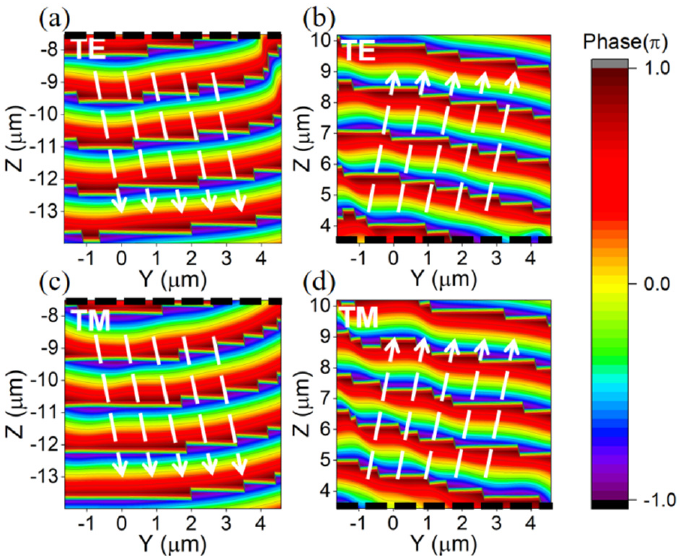
Figure 3. The Y − Z plane phase diagrams of the reflective and transmissive ends of the metasurface beam splitter under two types of line-polarized incident light at 1.55 µ m wavelength reflect the isophase plane of the outgoing light waves, with white arrows in the direction of the isophase plane vertical line, a black dashed line being the light-emitting surface of the metasurface, and different color stratifications representing different isophase planes. ( a ) The isophase plane of the reflective end under the incident x-line polarized light. ( b ) The isophase plane of the transmissive end under the incident x-line polarized light. ( c ) The isophase plane of the reflective end under the incident y-line polarized light. ( d ) The isophase plane of the transmissive end under the incident y-line polarized light.